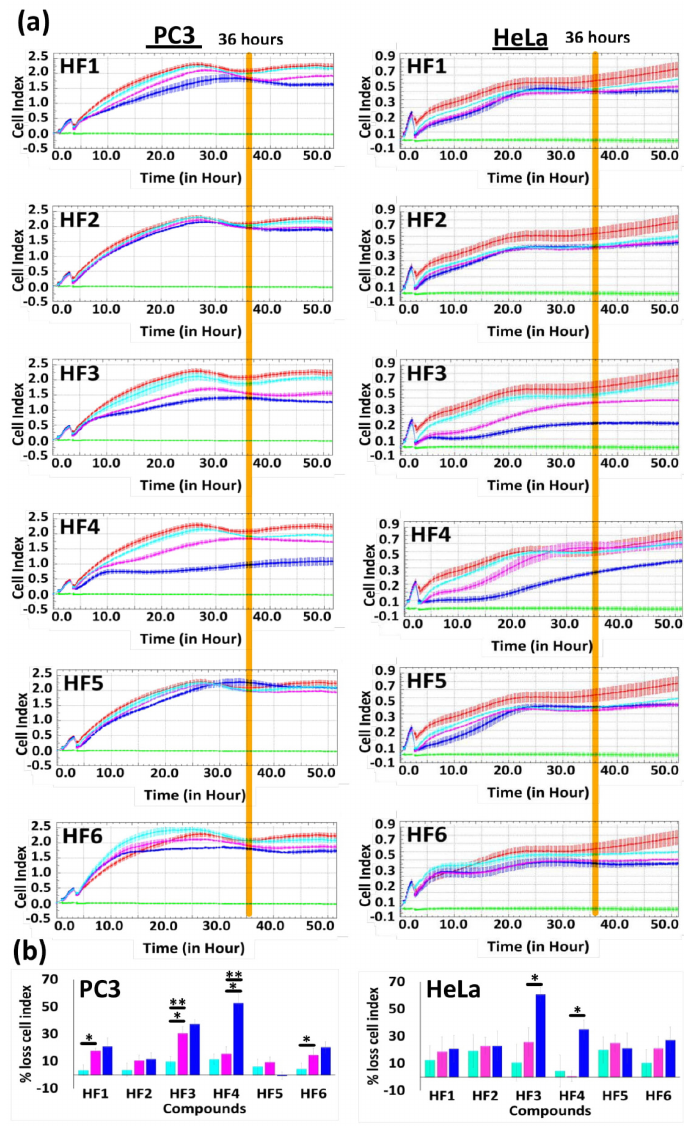
Figure 2. The anti-proliferative activities of flavonoids ( HF1-6 ) against PC3 (human prostate cancer) and HeLa (human cervical - - 100 µg/mL, 50 µg/ cancer ) cell lines ( - - - mL, 10 µg/mL, Control, Medium) 7,5’-dimethoxyisoetin (HF1), homoorientin- 6’’-4- O -methyl- myo -inositol (HF2), (2R, 3R) -(+)-dihydrokaempferol-7,4’-dimethylether (HF3), eriodictyol-7,4’-dimethylether (HF4), isoorientin (HF5) and genkwanin (HF6) Cell lines (2.5×10 4 cells/well) were plated to each well of the E-plate 96 and achieved to gain impedance 80 min prior to the addition of flavonoids at different concentrations. Cell index plots were given in (a) for 48 hours. Percent loss of cell index quantified in (b ) after 36 hours Results were expressed as mean ± standard deviation (n=3). *, p <0.05 and 0.01 **, p <0.001; Tukey and